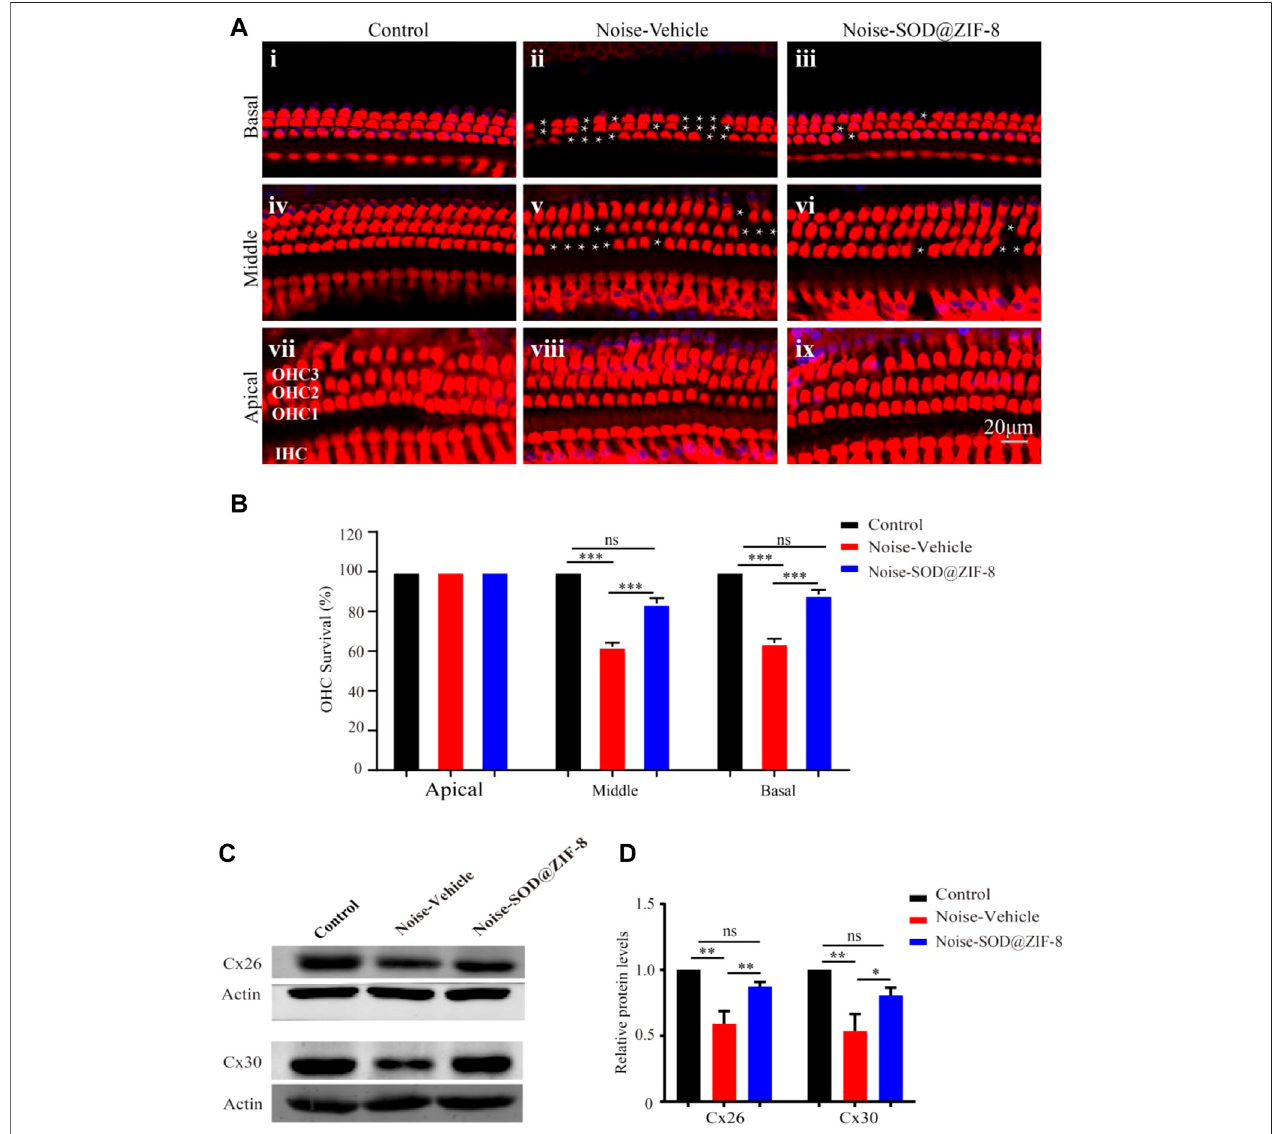
FIGURE4| Superoxidedismutase(SOD)@zeoliteimidazolateframework-8 (ZIF-8)protectedcochlear haircells(HCs)and endocochleargapjunctionsfromnoise- induced hearing loss (NIHL). (A) Representative images of surface preparation of the organ of Corti in the basal – apical cochlear turn from three groups of rats (Control, Vehicle,SOD@ZIF-8). (B) AnalysisofHCcountineachgroup. (C,D) ProteinexpressionlevelsandstatisticalanalysisofCx26andCx30inthecochleaeofvariousgroups. The white asterisk represents the missing outer hair cells (OHCs). Cyan represents 4 ′ 6 ′ -diamino-2-phenylindole, and red represents Myosin-VIIa. Data are presented as means ± standard error of mean (SEM) (* p < 0.05, ** p < 0.01, and *** p < 0.001, ns: no statistical signi fi cance).